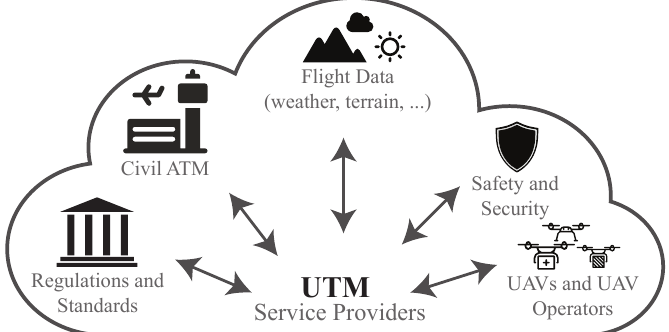
Figure 2. UAV traffic management (UTM) facilitating communication between main stakeholders